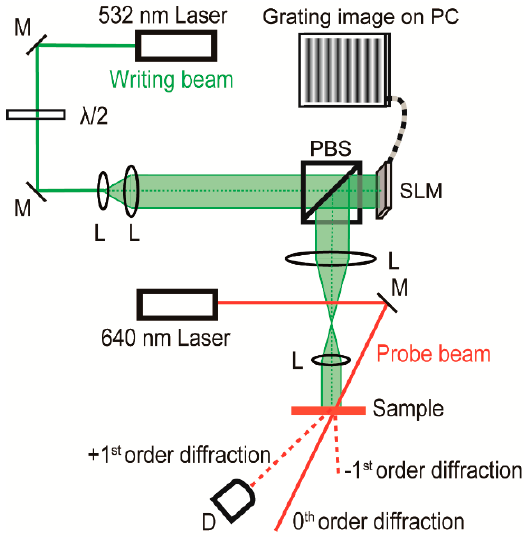
Figure 3. Schematic representation of the 4f reduction projection system: L—lens, M—mirror; PBS—polarizing beam splitter, PC—personal computer SLM—spatial light modulator, and D—photodiode. Laser sources are a green CW laser at 532 nm for recording and a red laser at 640 nm for reading.